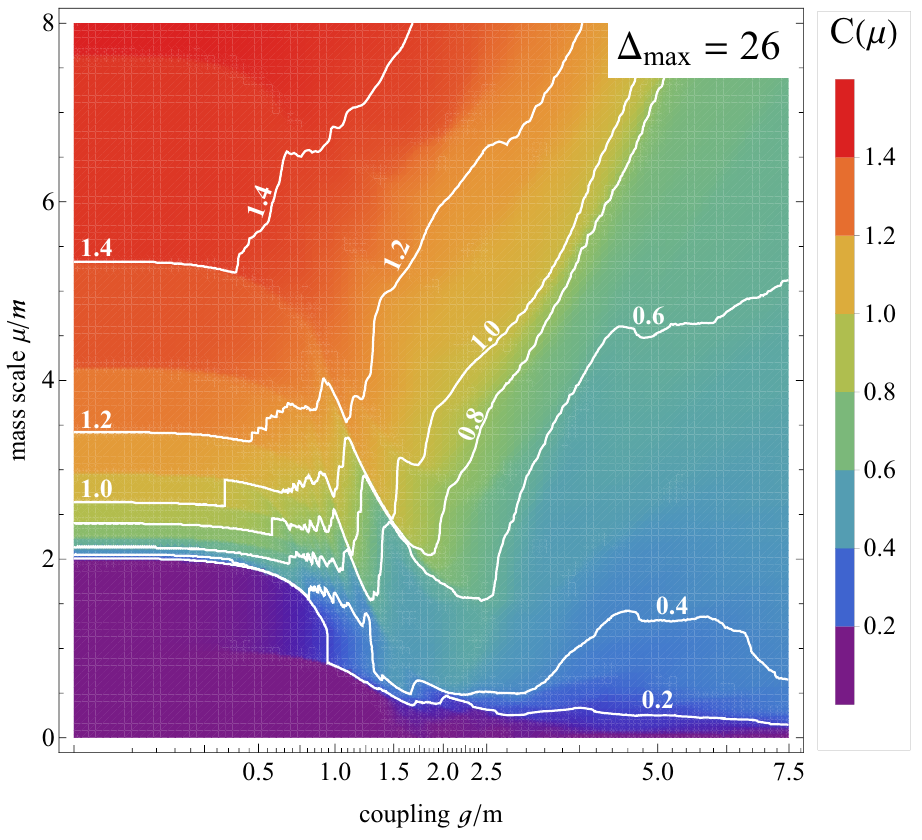
Figure 12 . Zamolodchikov C -function at different